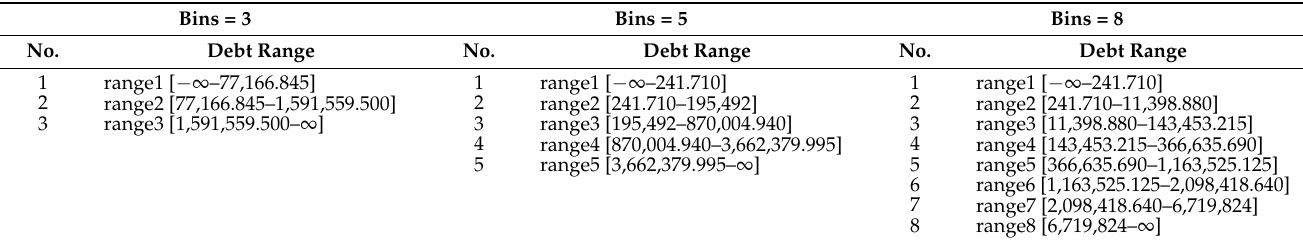
Table 4. Example debt ranges using binning with equal frequency (number of bins = 3, 5, and 8). Bins = 3 Bins = 5 Bins =